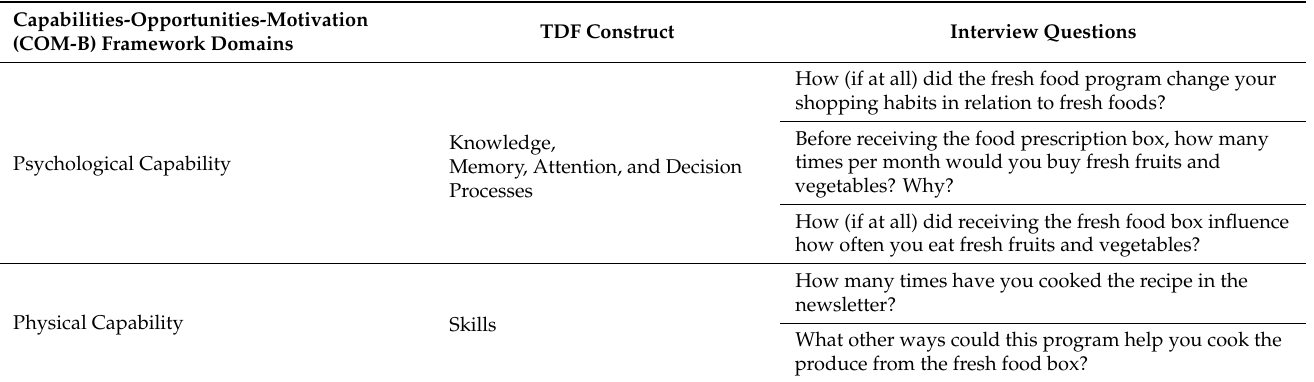
Table 2. Mapping of the COM-B to TDF Domains and Strategies to Develop the Semi-Structured Interview